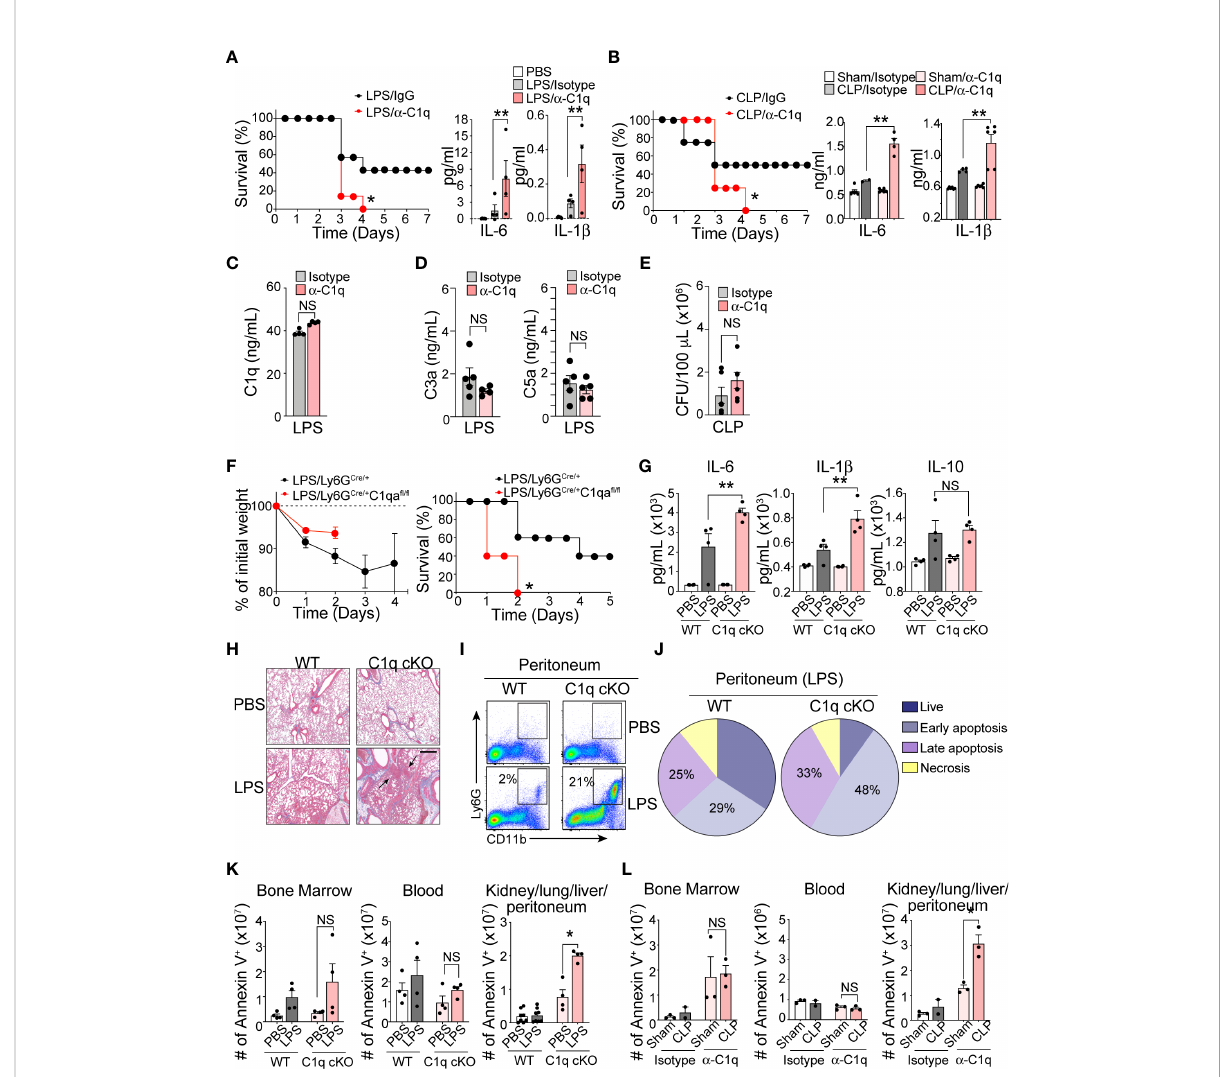
FIGURE 3 Neutrophil C1q is essential for sepsis survival. (A) , Left: Survival assay of LPS-induced endotoxemia mice treated intraperitoneally (IP) with isotype IgG control antibody or anti-C1q neutralizing antibody (10 m g/mouse) one hour prior to IP injection of LPS. n = 6 per group. Right: IL-6 and IL-1 b secretion in the serum 6 hours post-sepsis induction, data representative of three separate experiments. (B) , Left: Survival assay of CLP-induced sepsis in WT mice treated IP with isotype IgG control antibody or anti-C1q neutralizing antibody (10 m g/mouse) one hour prior to surgeries. n = 6 per group. Right: IL-6 and IL-1 b secretion in the serum of Sham or CLP WT mice treated with either isotype control IgG antibody or anti-C1q neutralizing antibody one hour prior to surgeries. ELISA was measured 24 hours post-sepsis induction, data pooled from two experiments. (C) , Total C1q secretion in the serum of WT mice IP-treated with 15 mg/kg of LPS and either isotype control IgG antibody or anti-C1q neutralizing antibody 1 hour prior to LPS injection. ELISA measured 6 hours post-sepsis induction, n = 6 per group. (D) . Quanti fi cation of the serum C3a and C5a in LPS- treated mice using ELISA (n = 5 mice/group). (E) Bacterial loads in the blood of septic mice were measured at 48 h of post-CLP. The bacterial colonies grown on the blood agar plates were calculated as CFU per mL of blood (n = 5 mice in each group). (F) . Sepsis severity ( left ) and survival curves ( right ) of Ly6G Cre/+ :C1qa +/+ (WT) or Ly6G Cre/+ :C1qa fl / fl mice (C1q cKO) mice treated with 15mg/kg LPS, n = 5 mice per group. (G) , IL-6, IL-1 b , and IL-10 secretion in the serum of WT or C1q cKO mice treated with PBS (white bars = WT, light pink bars = cKO) or LPS (grey bars = WT, dark red bars = cKO), n = 4 per group. (H) , Histological analysis of the in fl amed lung in Ly6G Cre/+ C1qa +/+ vs. Ly6g Cre/+ C1qa fl / fl mice 24 hours after PBS or 18 mg/kg of IP LPS injection using Masson ’ s trichrome staining. White arrows indicate blood vessels. Scale bars, 40 m m. (I) , Typical fl ow cytometry pro fi le of neutrophils in the peritoneum during acute LPS stimulation for 36 h (n = 3 – 4 mice per group). (J) , The pie charts depict the proportion of live, necrotic (PI + and Annexin − ), and early (PI − and Annexin + ) and late (PI + and Annexin + ) apoptotic populations in each group. Data are presented as mean of n = 3. (K) , Number of apoptotic neutrophils accumulated in the bone marrow, blood, and peripheral organs (kidneys, lungs, liver, peritoneum pooled) measured in absolute number of Ly6G + /annexin V + cells. WT vs C1q cKO treated with PBS or LPS (n = 4 per group). (L) , Number of apoptotic neutrophils in Sham surgery vs. CLP mice with IgG isotype control or anti-C1q antibody (n = 3 mice per group). Data are presented as mean ± SEM. Data were analyzed by Mantel-Cox for (A, B, F) , ordinary one-way ANOVA with Tukey ’ s multiple comparison post-test or two-way ANOVA in (A – E, K, L) . (*P < 0.05; **P < 0.01). NS, not signi fi